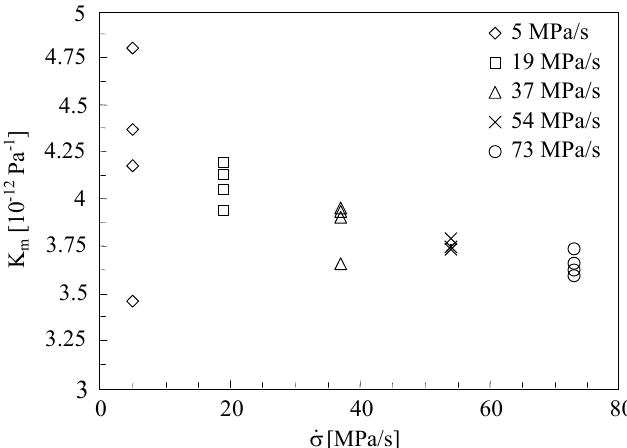
Figure 8: Experimental evaluation of the thermoelastic constant K m of the analysed